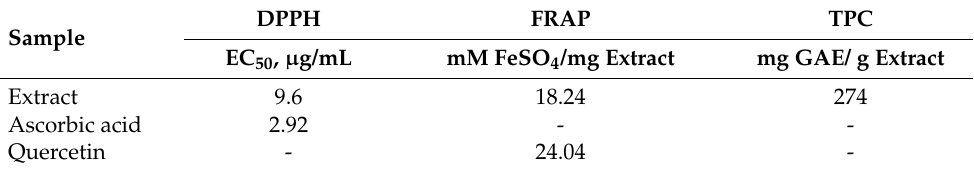
Table 3. TPC and antioxidant activity of H. abyssinica extract in DPPH and FRAP assays.